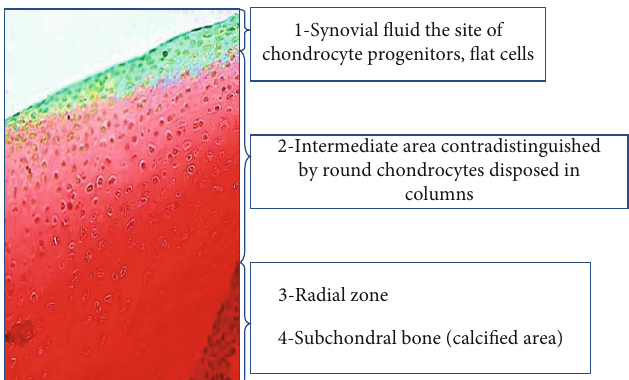
Figure 1: Structure of human cartilage. The cartilage tissue consists of 4 di ff erent substrates: 1, the super fi cial area, a mélange of synovial fl uid, chondrocytes, stem cells, and fl at cells; 2, an intermediate zone; 3, the radial zone; and 4, the subchondral calci fi ed area close to the